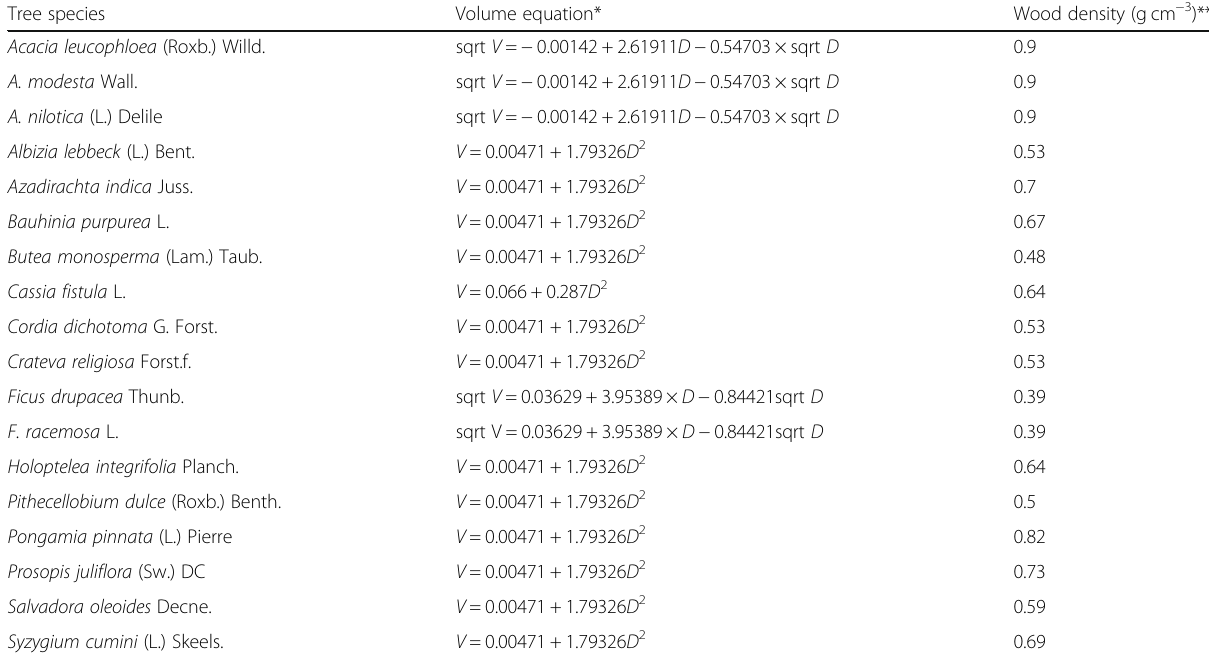
Table 1 Volume equation and wood density of tree species Tree